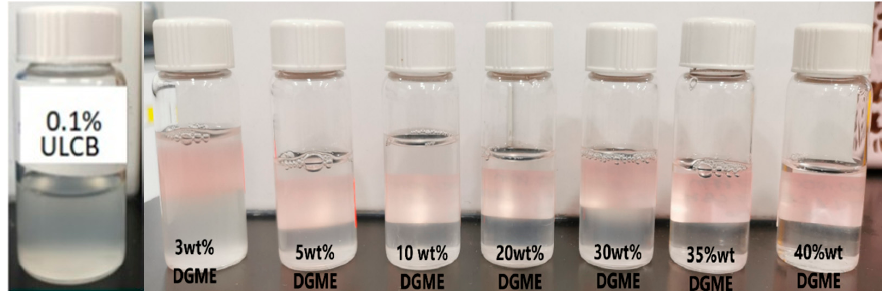
Figure 4. Solubility of 0.1 wt.% surfactant with 3, 5, 10, 20, and 30 wt.% diethylene glycol mono butyl ether (DGME) compared to 0.1 wt.% as-synthesized surfactant in seawater (ULCB). Table 3. Turbidity value for as-synthesized surfactant with the presence of DGME. Concentration (%) Turbidity (NTU)